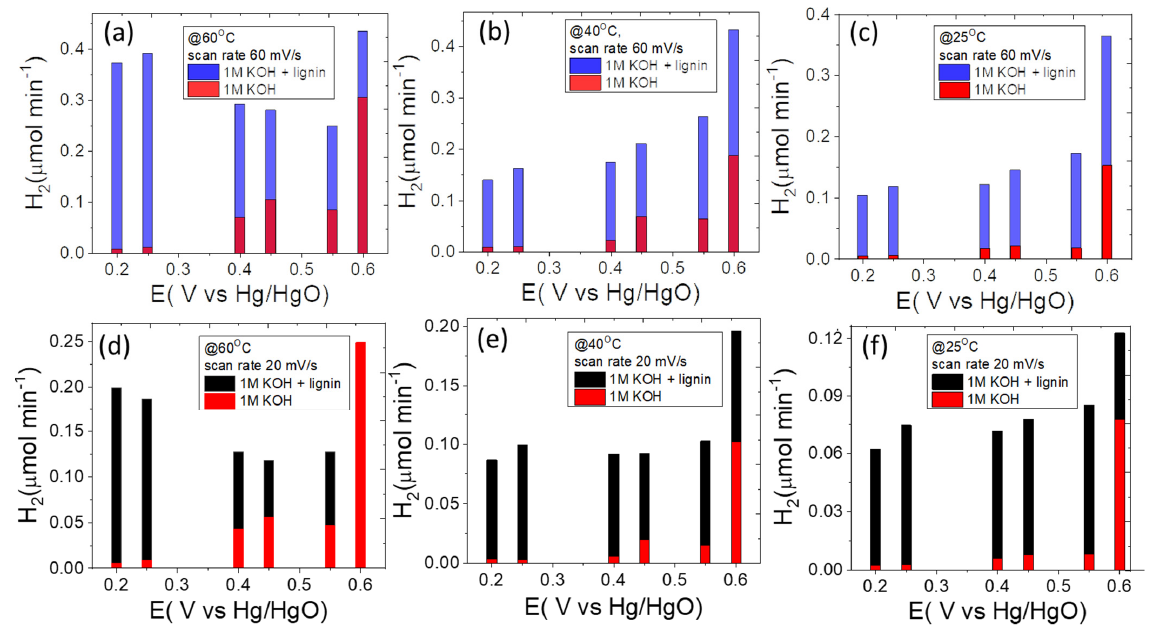
Figure 8. ( a – f ) Theoretical hydrogen production ( μ mol.s − 1 ) in conventional water electrolysis and in lignin electro-oxidation at different temperatures and scan rates for the catalyst P-NiFeCo/NC.